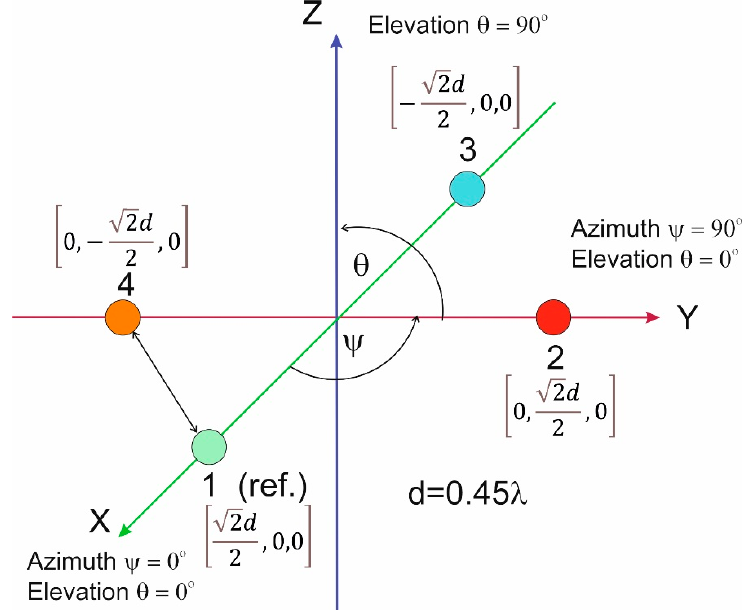
Figure 5. Arrangement of antennas receiving navigation signals.